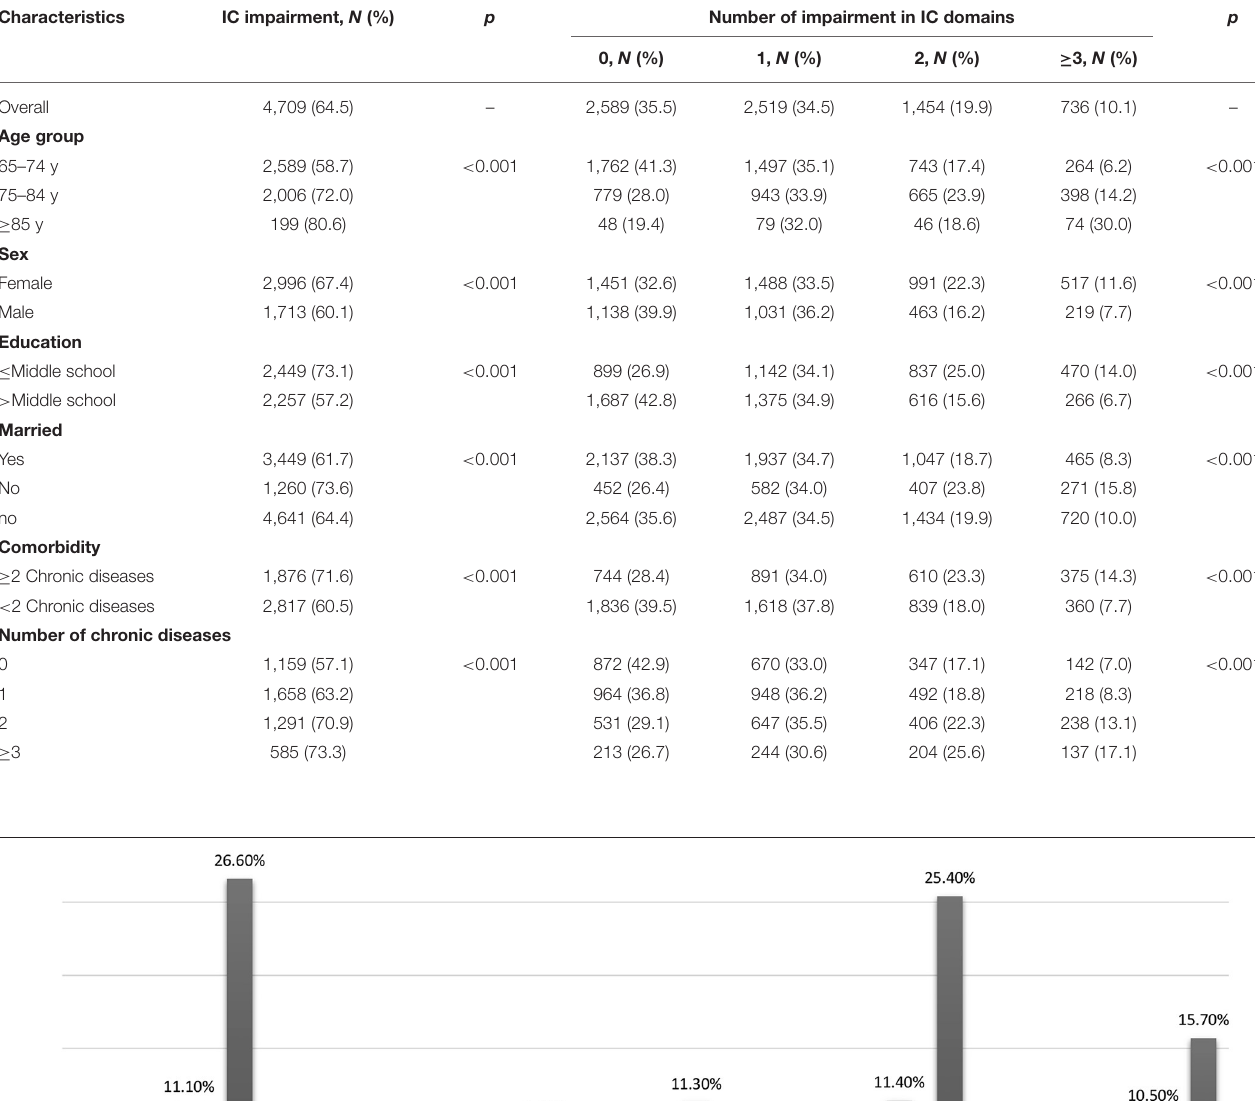
TABLE 2 | Prevalence of overall IC impairment and as categorized by the impairment in intrinsic capacity (IC) domains at baseline. Characteristics